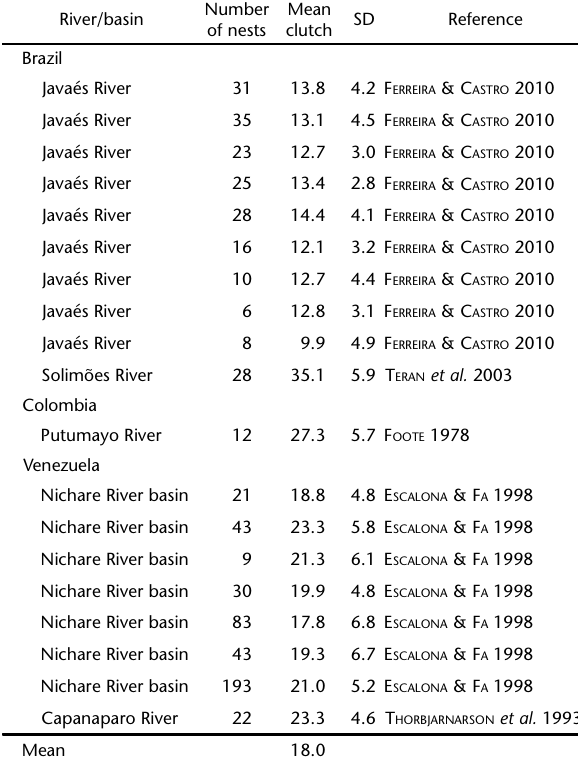
Number Mean of nests clutch